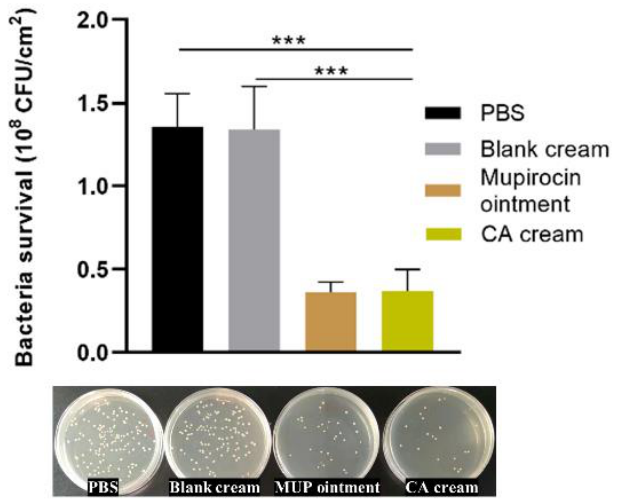
Figure 6. In vitro and in vivo antibacterial activities of CA cream. The number of S. aureus in infected skin was determined by the number of colonies in the TSA plate. Statistical analysis was expressed as the mean ± SD, using a one-way ANOVA or Student’s t -test. The data were considered as statistically significant difference when *** p < 0.001 versus the indicated group.